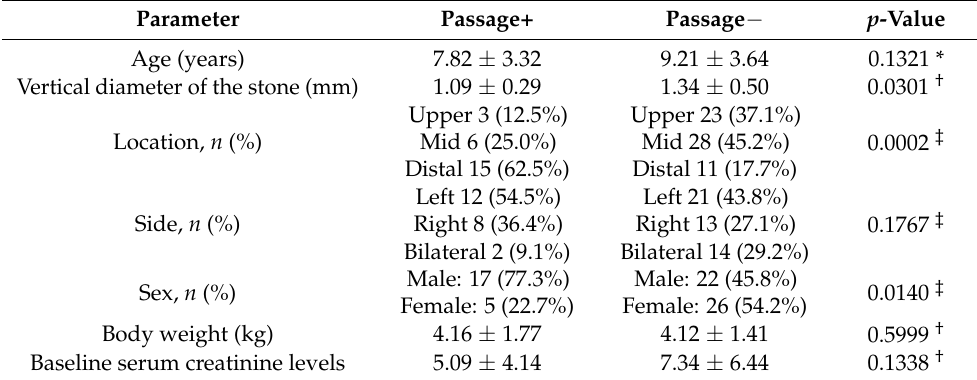
Table 2. Comparison of baseline characteristics for location and side of the